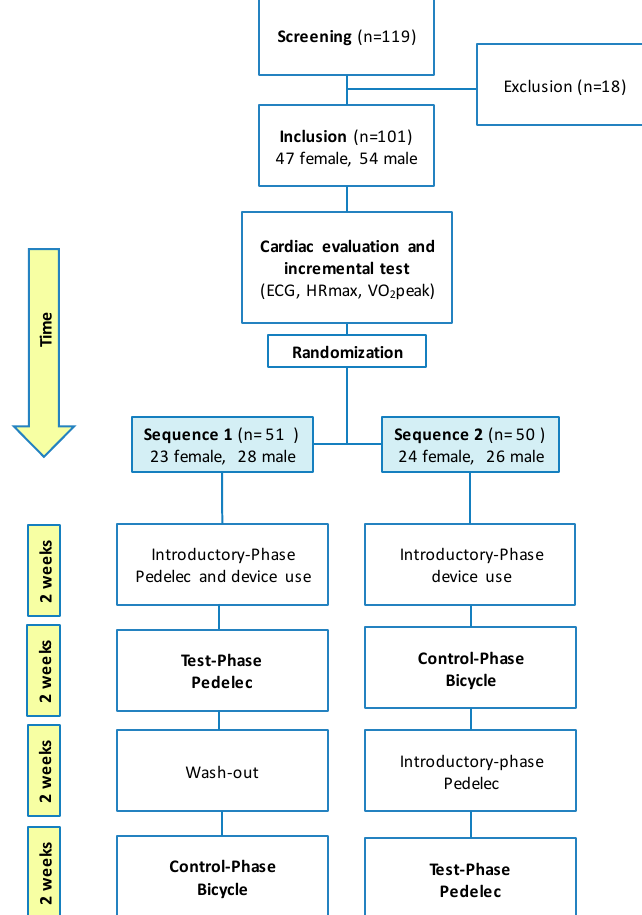
Figure 1. Flow chart of the study. Note the crossover design of sequences enabling each participant to be included in both groups, pedelec test group (P) and bicycle control group (B).